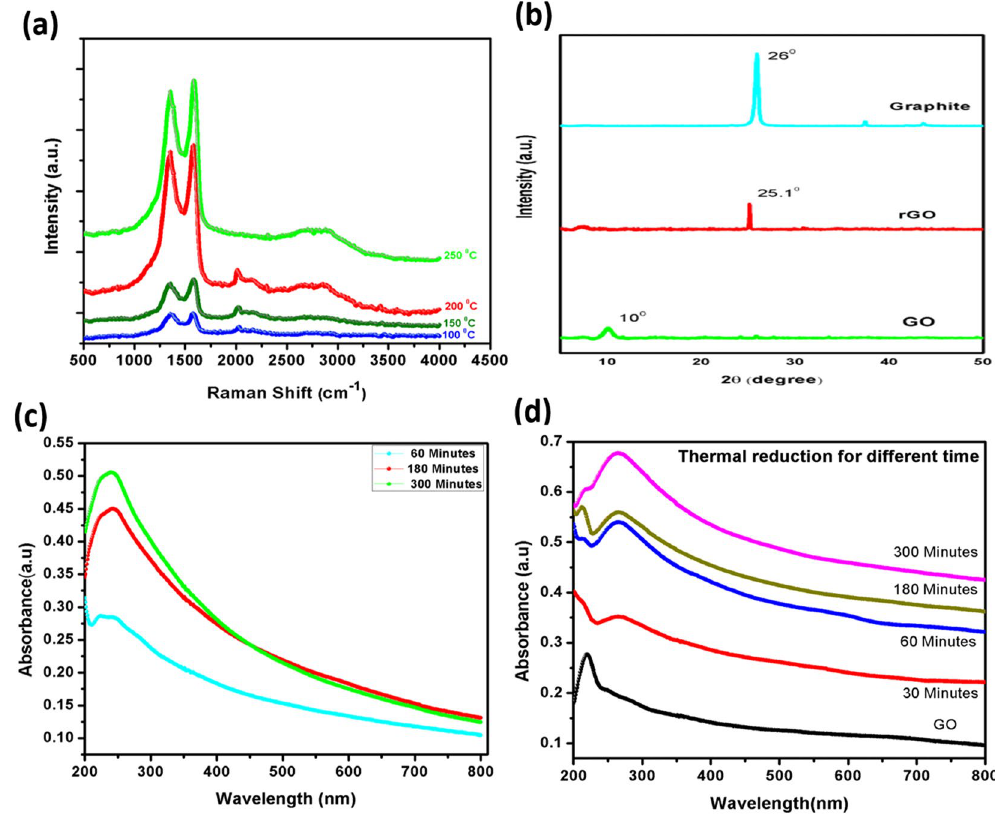
Figure 3. ( a ) Raman spectra of reduced graphene oxide (rGO) film at different thermal reduction temperature. ( b ) XRD patterns of graphite, GO, and rGO films. UV-Vis spectra of ( c ) GO dispersion as a function